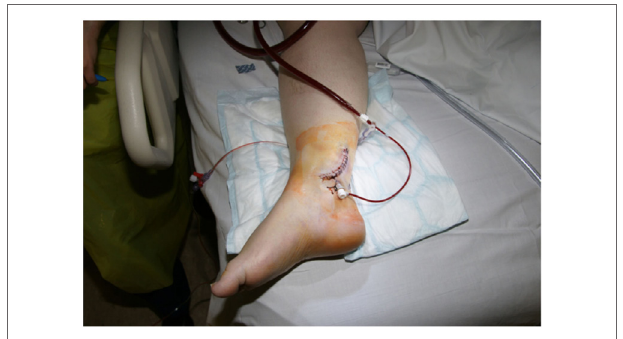
FigURe 3 | Cannulation of posterior tibial artery allowing retrograde perfusion of